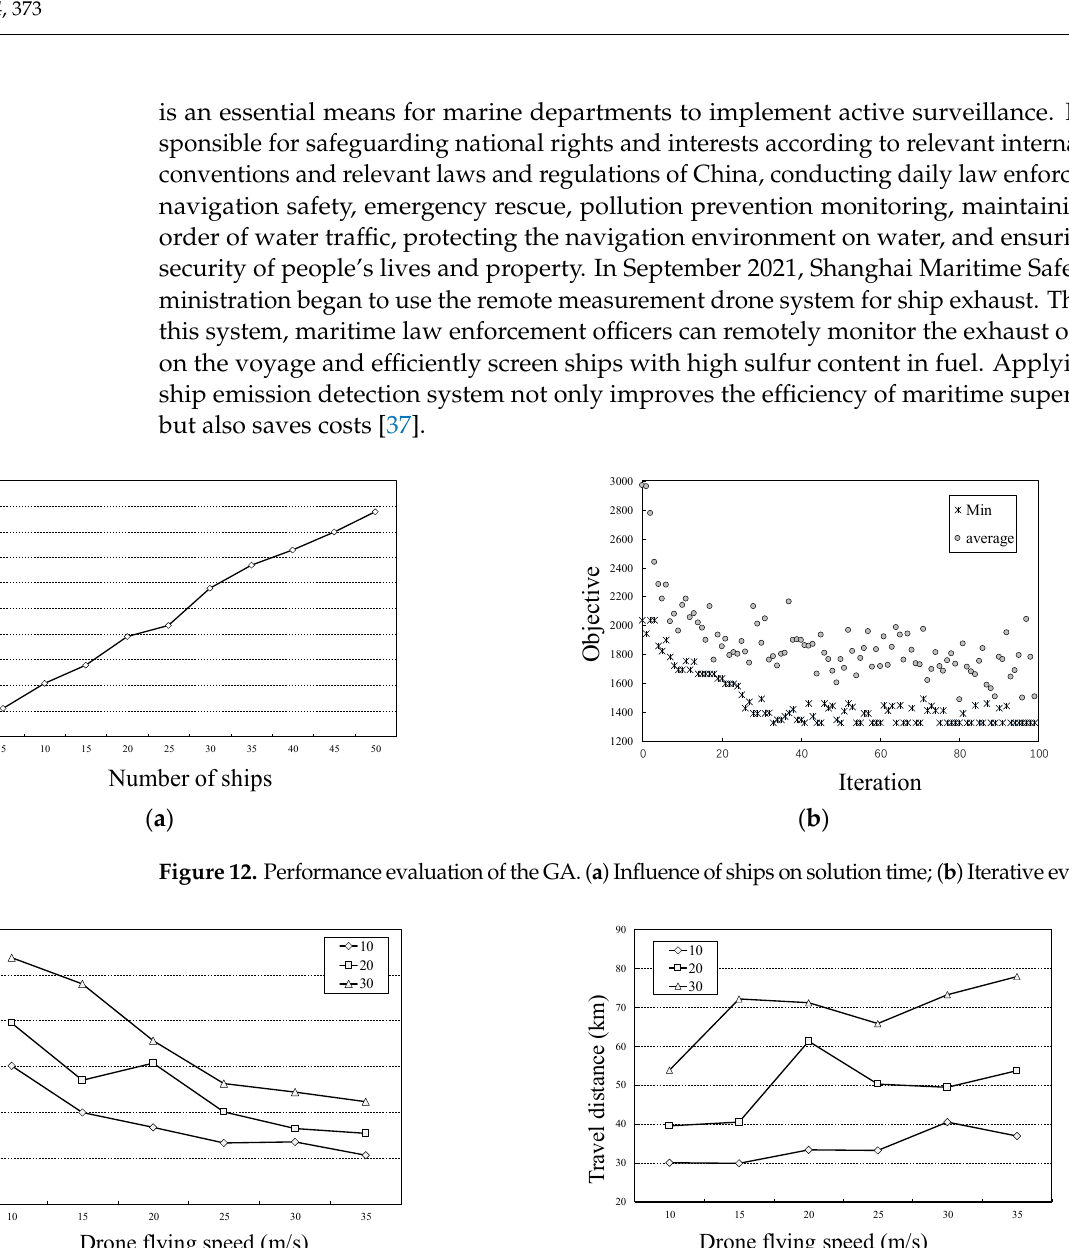
Figure 11. Influence of crossover rate and mutation rate on genetic algorithm.